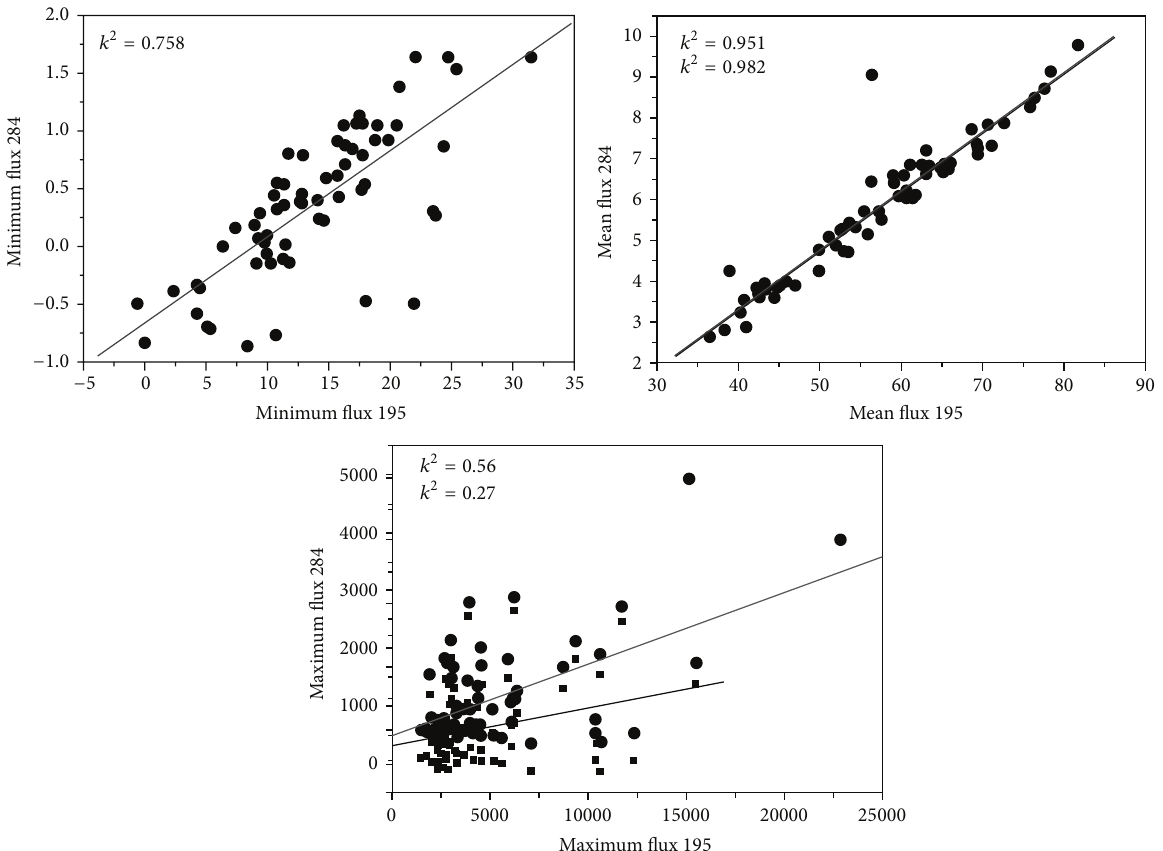
Figure 3: Comparison of the calculated minimum, mean, and maximum brightness values in two lines.